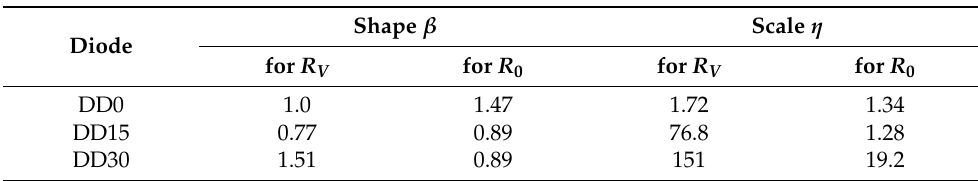
Table 3. Shape and scale parameters of the Weibull distribution function for experimental voltage responsivity R V and electrical resistance R 0 data.